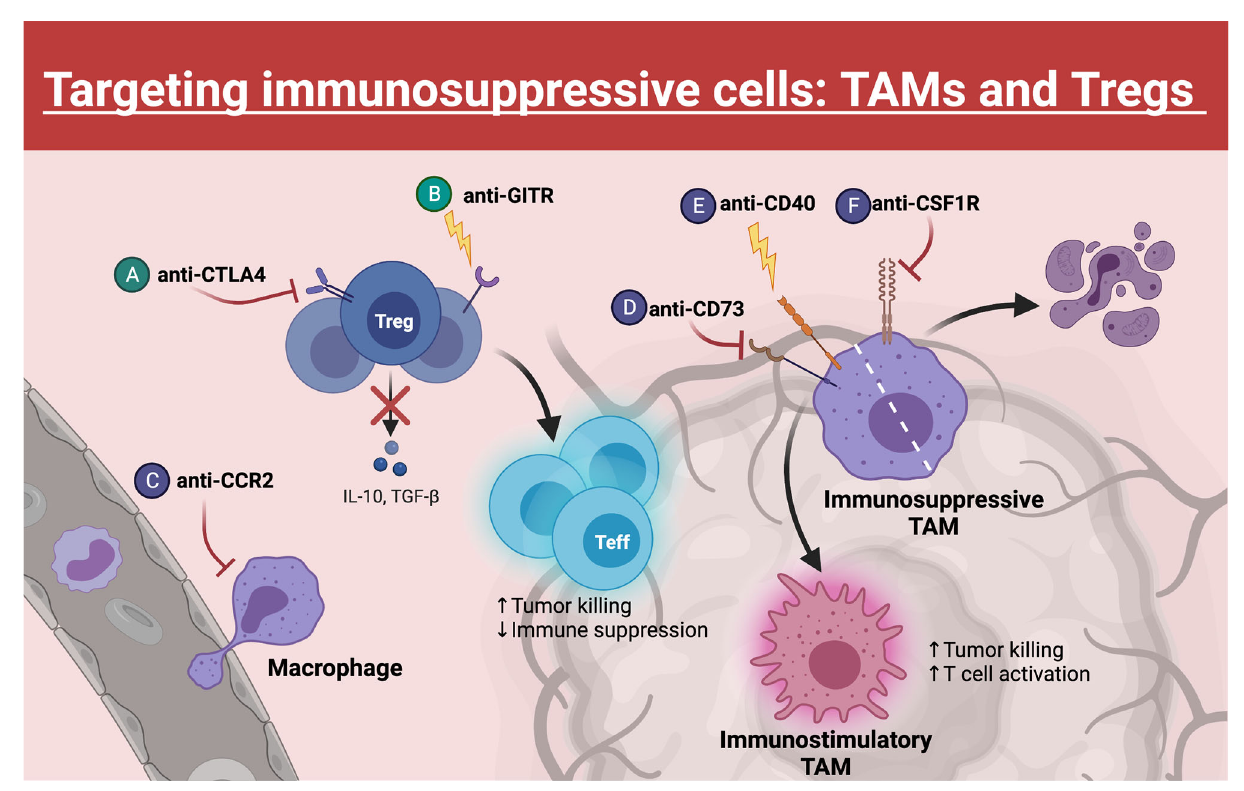
FIGURE 3 | Targeting TAMs and Tregs. Within the TME, Tregs and TAMs represent major barriers to effective anti-tumor T cell function. Many emerging therapies have been developed to target these populations, which often synergize with immune checkpoint blockade. (A) Blocking CTLA4 on Tregs decreases their immunosuppressive function, whereas (B) GITR agonism can destabilize Tregs, causing these Tregs to gain effector function. (C) TAM traf fi cking to the tumor can be inhibited through blockade of surface CCR2. (D, E) Repolarizing TAMs from an immunosuppressive phenotype to an immunostimulatory phenotype can be achieved through CD73 inhibition or CD40 agonism. (F) Another strategy to eliminate TAMs within the TME is blocking of CSF1R, a critical growth receptor on TAMs, which leads to cell death. Created with